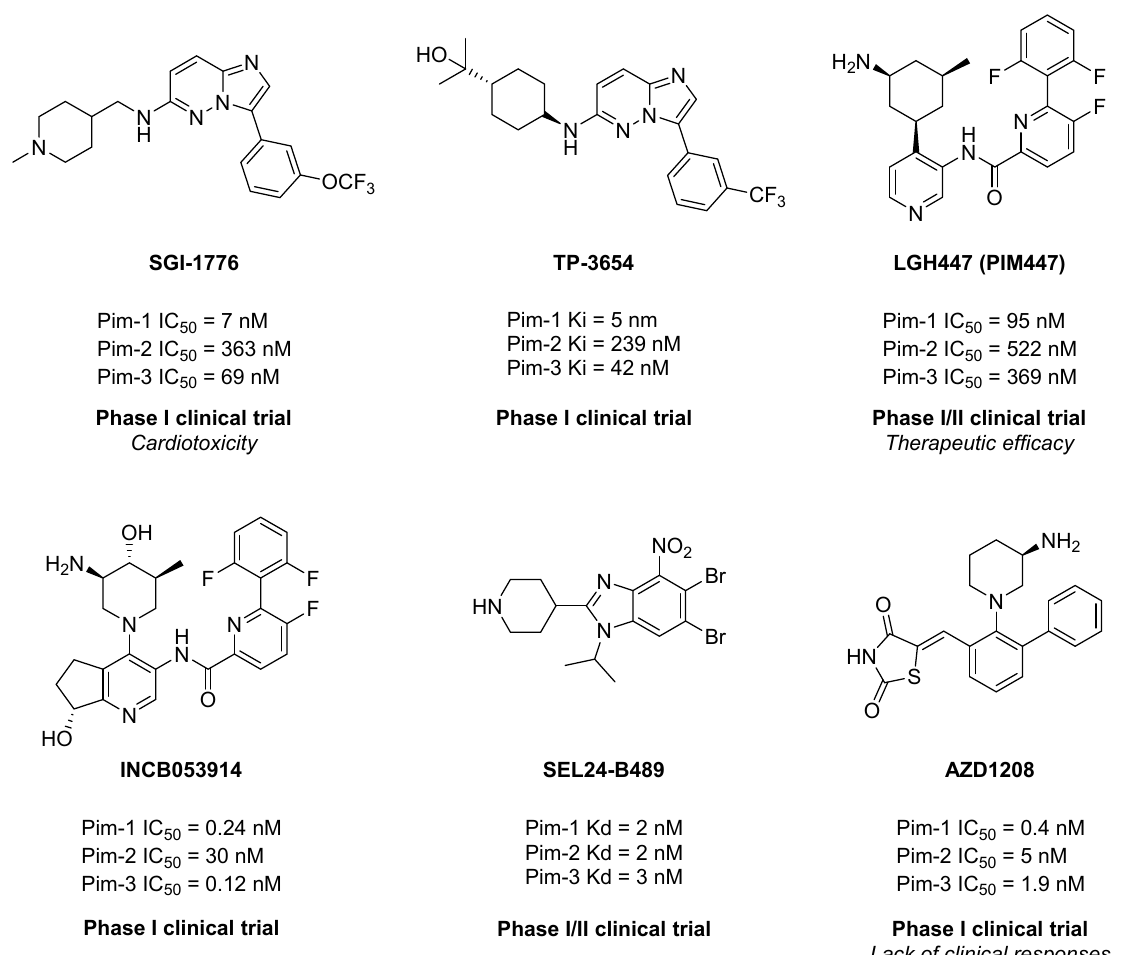
Figure 1. Selection of the most representative and/or promising proviral integration site for Moloney murine leukemia virus (Pim) inhibitors.